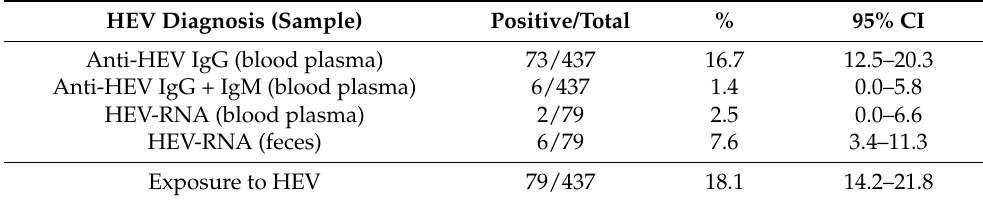
Figure 2. Characteristics presented by the participants in this study. ( A ) Pipes prepared manually and used to smoke crack-cocaine. ( B ) PWUCC living on the street. Table 2. Laboratory markers of hepatitis E virus (HEV) detected in people who use crack-cocaine in a remote region of northern